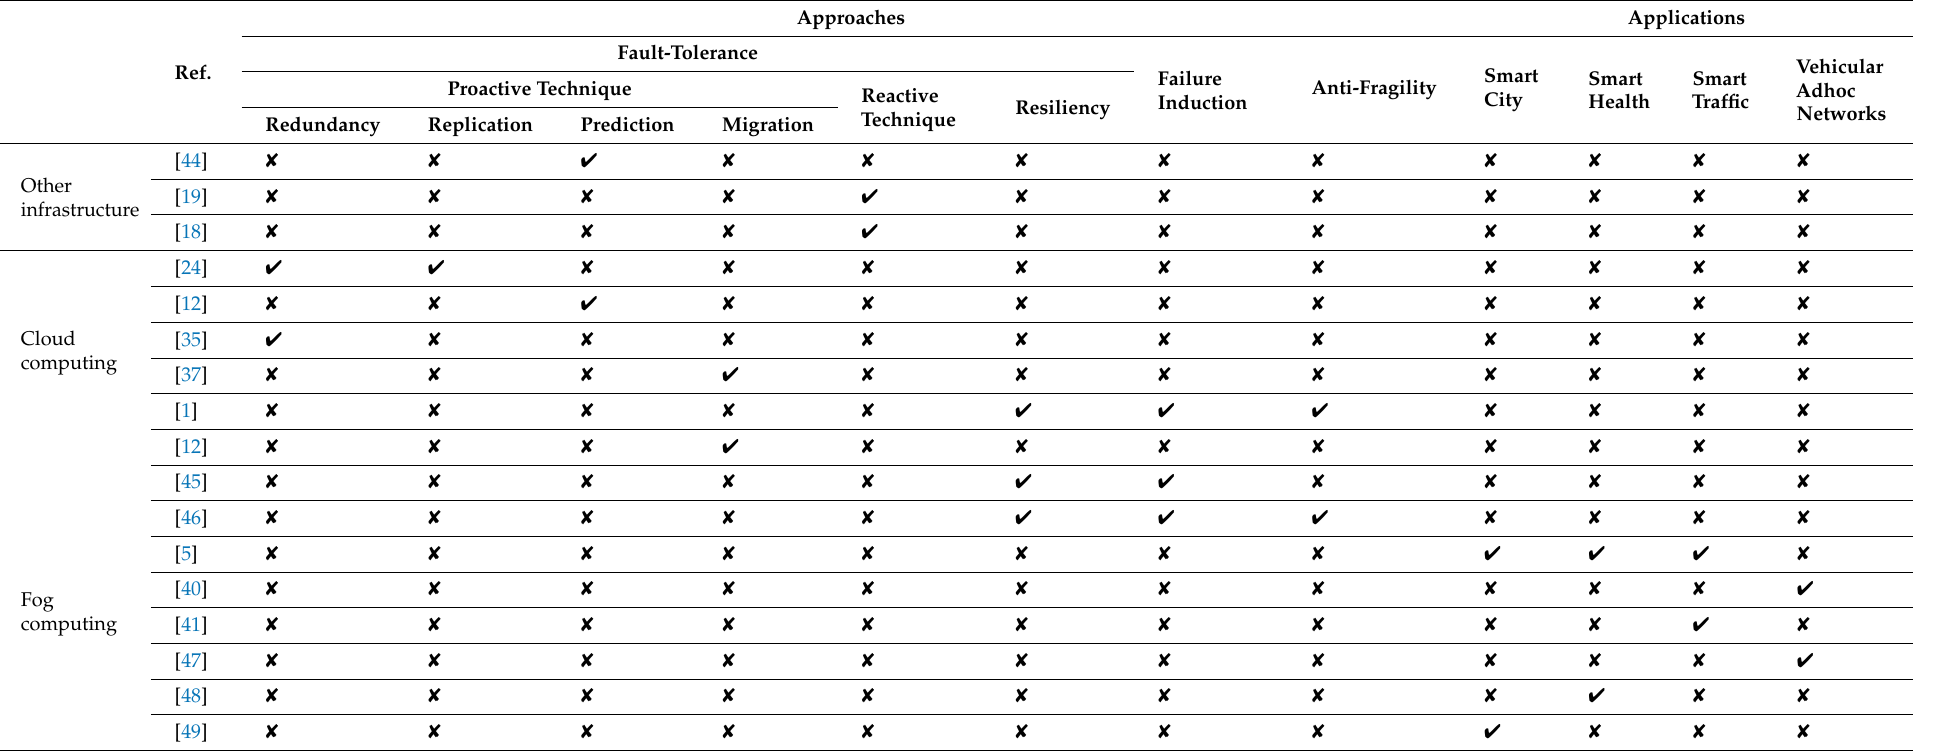
Table 2. Analytical summary of the literature